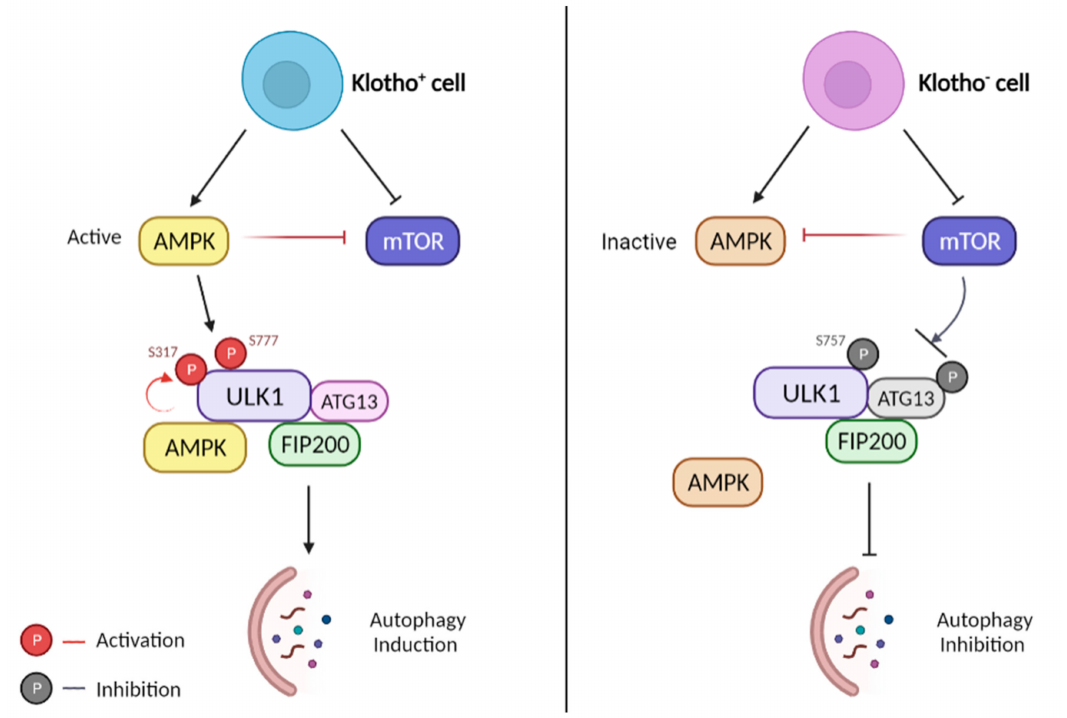
Figure 4. Role of Klotho protein in ULK1-induced autophagy. Left: Klotho overexpression. AMPK is active and mTOR is inhibited by AMPK and Klotho protein. ULK1 is subsequently phosphorylated by active AMPK at sites Ser 317 and 777. The complex of ULK1/ATG13/FIP200 is formed and autophagy is promoted. Right: Klotho deficiency. AMPK becomes inactive while mTOR becomes active. Activated mTOR phosphorylates ULK1 on Ser757, preventing ULK1 from interacting with AMPK, suppressing the formation of the ULK1 complex, and inhibiting